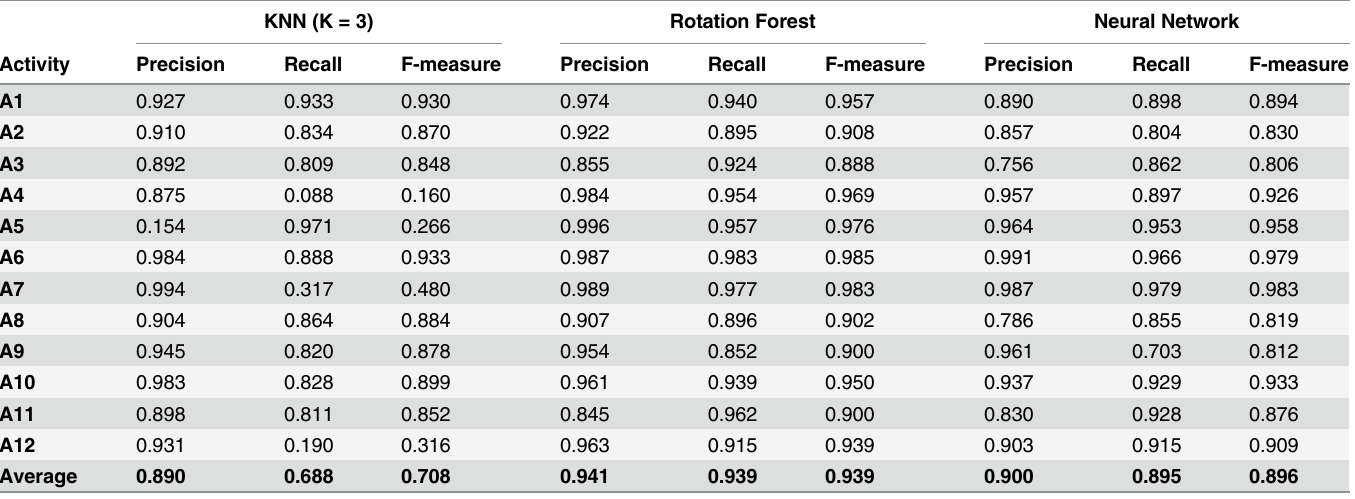
Table 2. Classification results of three classifiers using the acceleration sensor placed at dominant wrist. KNN (K = 3) Rotation Forest Neural